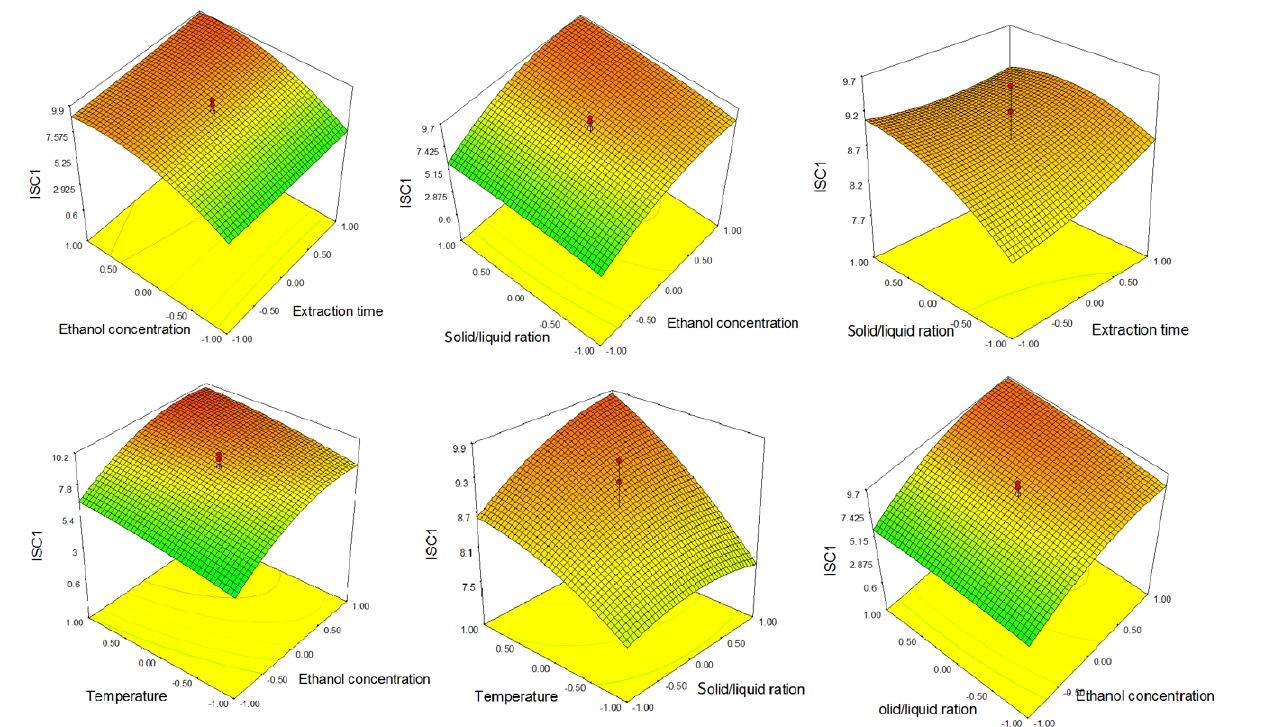
Figure 3. Response surfaces showing the combined effect of parameters on isoscutellarein 7- O -[6 (cid:48)(cid:48)(cid:48) - O -acetyl- β - D - allopyranosyl-(1 → 2)]- β - D -glucopyranoside (ISC